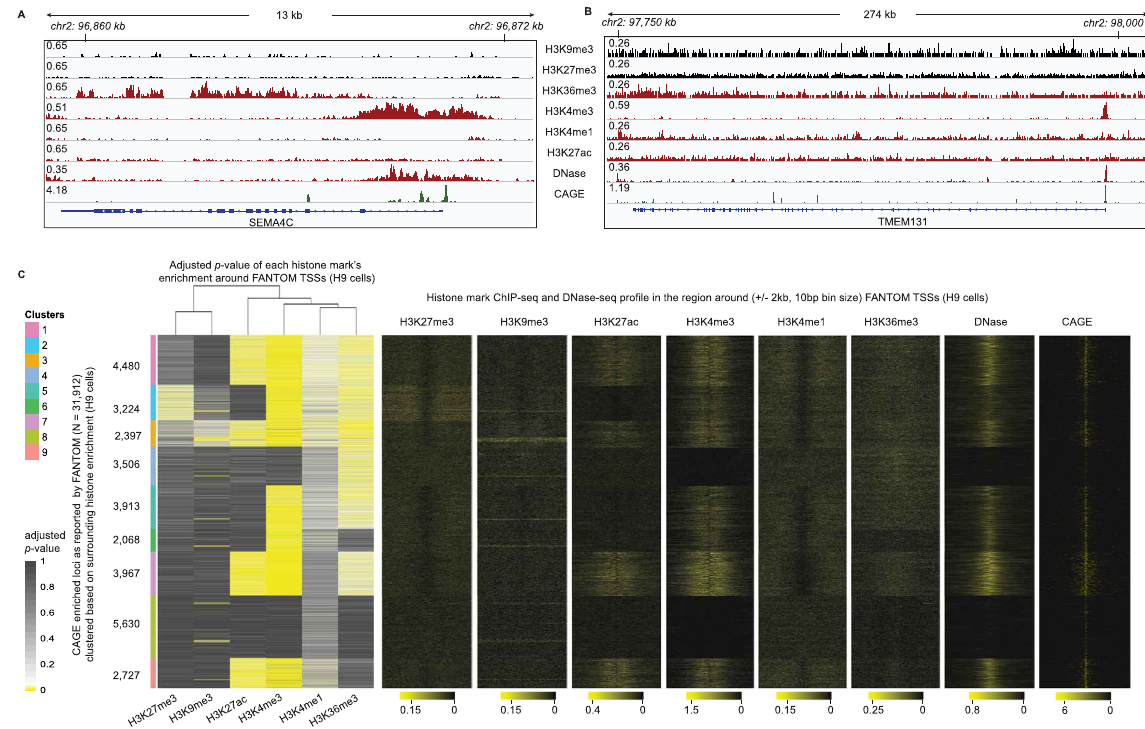
Figure 2. Genome-wide analysis of the chromatin landscape surrounding CAGE enriched loci in H9 cells as reported by FANTOM. Examples of ( Α ) SEMA4C and ( Β ) TMEM131 loci with tracks from six histone marks showing chromatin status, DNase-Seq unveiling accessibility and the raw CAGE signal. Active or poised promoters are denoted with H3K4me3 and H3K27ac, active or poised enhancers with H3K4me1 and H3K27ac, repressed chromatin with H3K27me3 and H3K9me3, and transcribed regions with H3K36me3. As indicated by the CAGE signal, there are multiple CAGE enriched regions located in introns and exons of SEMA4C and especially of TMEM131 with length over 200 kb. The ones located in promoter regions exhibit increased chromatin accessibility while the rest are located in inaccessible chromatin. ( C ) 31,912 FANTOM CAGE peaks were clustered based on the enrichment of six histone marks (H3K4me3, H3K27ac, H3K4me1, H3K36me3, H3K9me3 and H3K27me3). On the right side, histone ChIP-, DNase-Seq and CAGE signal profile is also shown. We observe that 61.3% (19,552) of CAGE peaks exhibit active histone mark enrichment and the remaining 38.7% (12,360) do not demonstrate any chromatin activity showcasing the increased transcriptional noise level embedded in CAGE